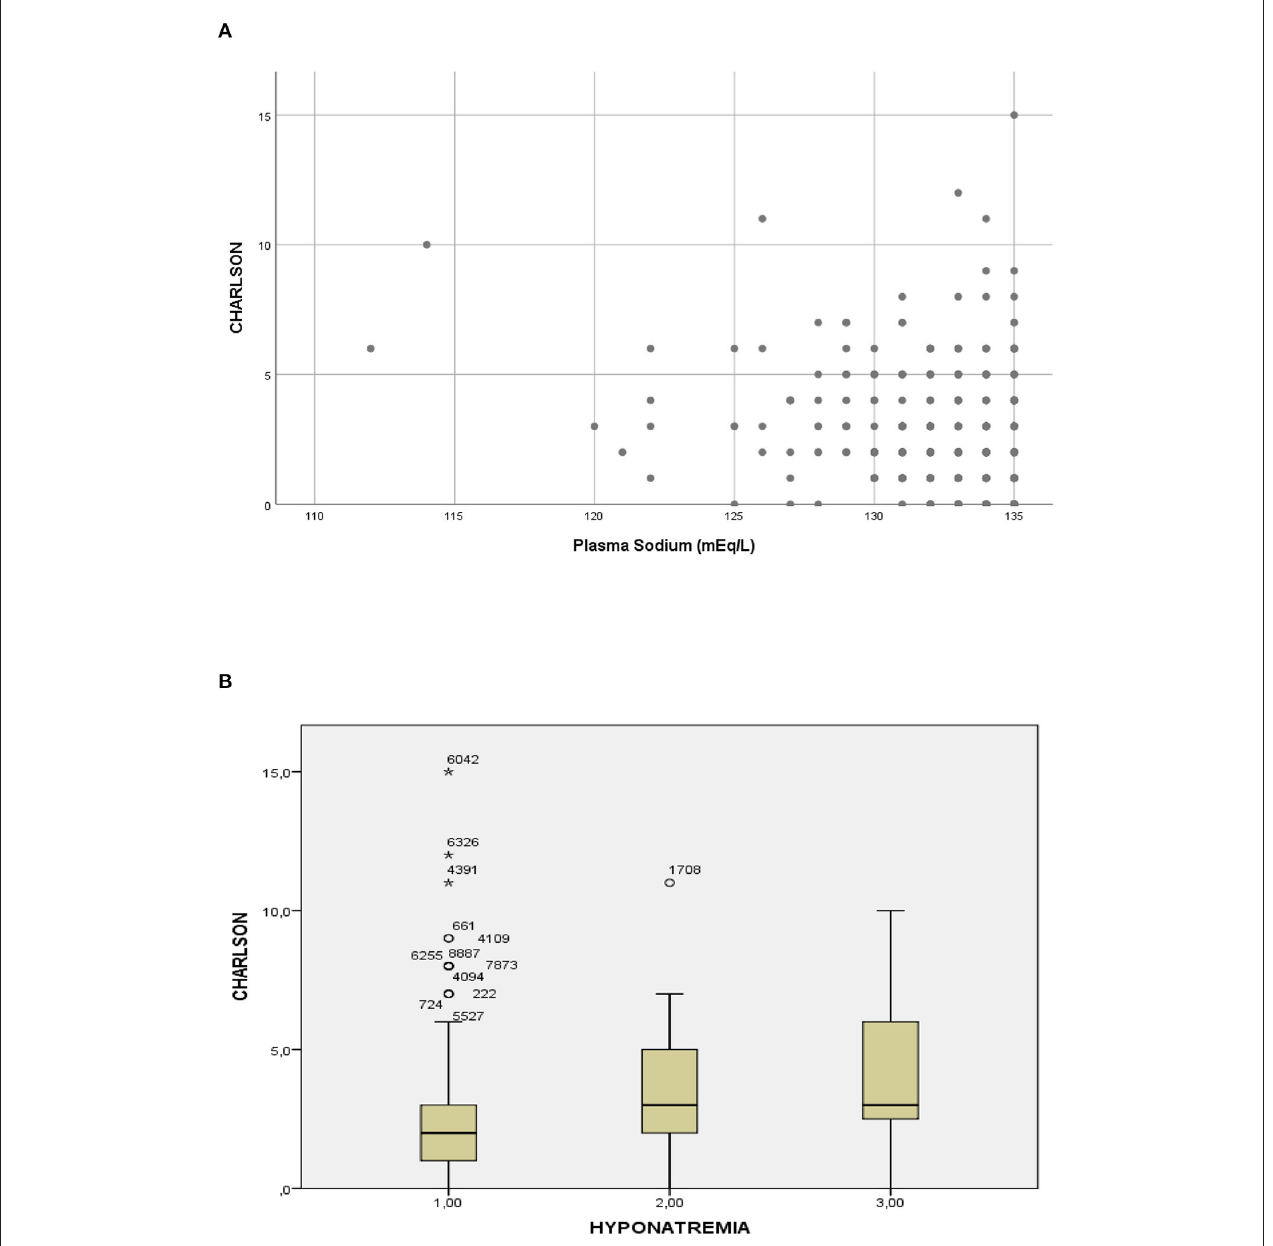
FIGURE 2 | Relationship between plasma sodium and the Charlson comorbidity index. (A) Scatterplot of the Charlson comorbidity index according to the plasma sodium (Spearman test: rho = 0.21; p < 0.01). (B) Boxplot of the Charlson comorbidity index according to severity of hyponatremia, group 1 ≤ 126 mEql/L, group 2 = 126–130 mEq/L and group 3 = 131–135 Eq/L (Kruskal-Wallis test: p <